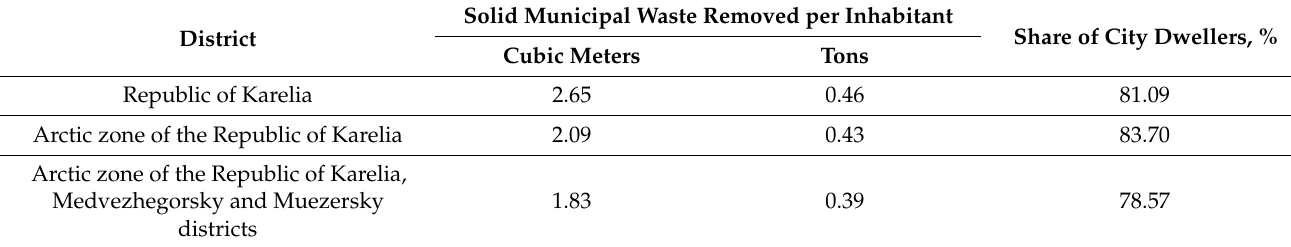
Table 4. Indicators of solid municipal waste collection in